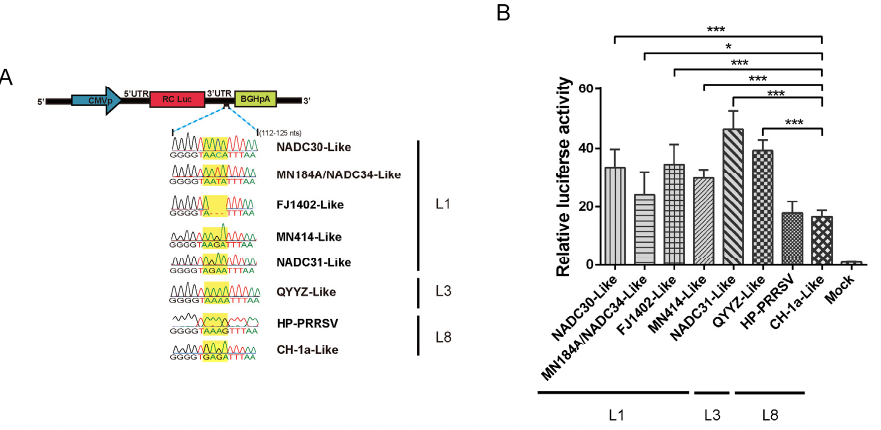
Figure 6. The effects of different 3 ′ -UTR motifs on PRRSV replication. ( A ) Schematic diagram of luciferase plasmids used for Luciferase reporter assay analysis. ( B ) The effects of different 3 ′ -UTR motifs on PRRSV replication. The 3 ′ -UTR mini-genome system mutant plasmids and Renilla luciferase plasmid were co-transfected to Marc-145 cells. After 24 h post-transfection, cells were infected with 0.1 MOI PRRSV HuN4 for another 24 h, and then firefly luciferase activity was measured. Asterisk (*) indicates a significant difference between parental and mutant viruses. ( * , p < 0.05; *** , p < 0.001).